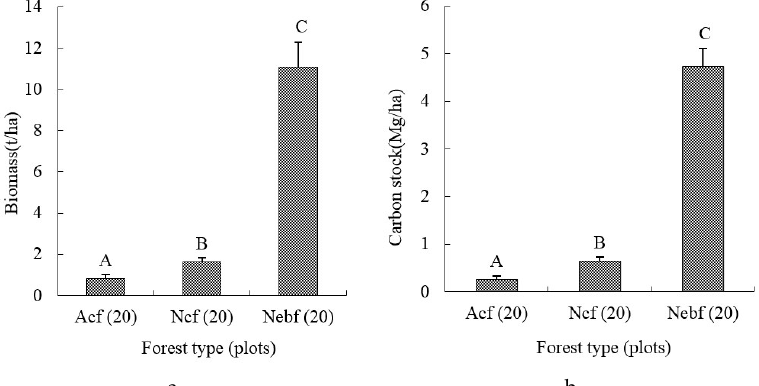
Figure 1. Biomass ( a ) and carbon stock ( b ) of fallen trees in artificial and natural forest. Acf , artificial coniferous forest; Ncf , natural coniferous forest; NEbf , natural evergreen broad-leaved forest; Different uppercase letters indicate significant differences among different forest types ( Acf , Ncf or Nebf ) at p < 0.05. Table 2. Biomass and carbon stock of fallen trees for different stand and forest types. Stand Types (Plots)